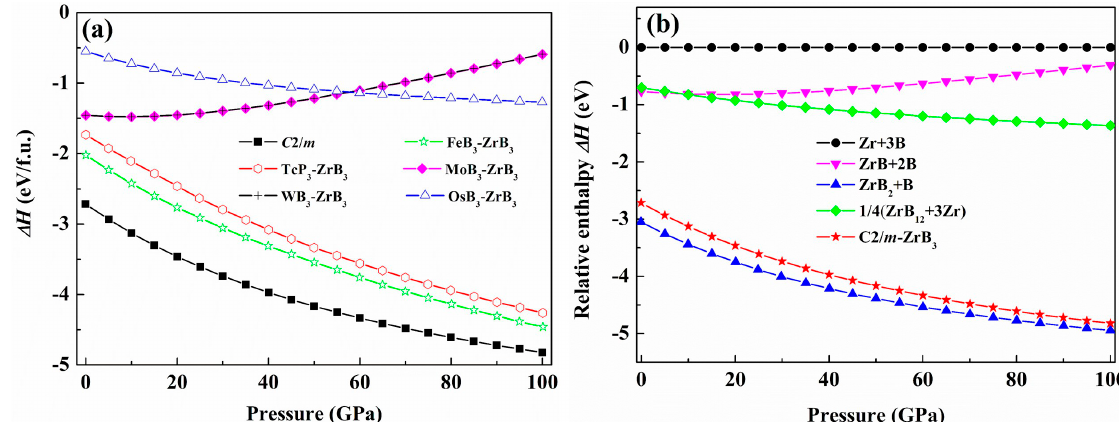
Figure 4. ( a ) The formation enthalpy-pressure curves for ZrB 3 with six different structures; ( b ) The relative enthalpy-pressure curve of the C 2/ m -ZrB 3 and its respective competing phases with respect to elemental Zr and B.